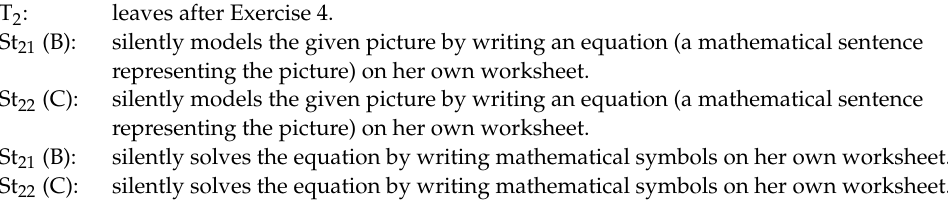
Pair Work Condition Paper-and-Pencil Tangible App